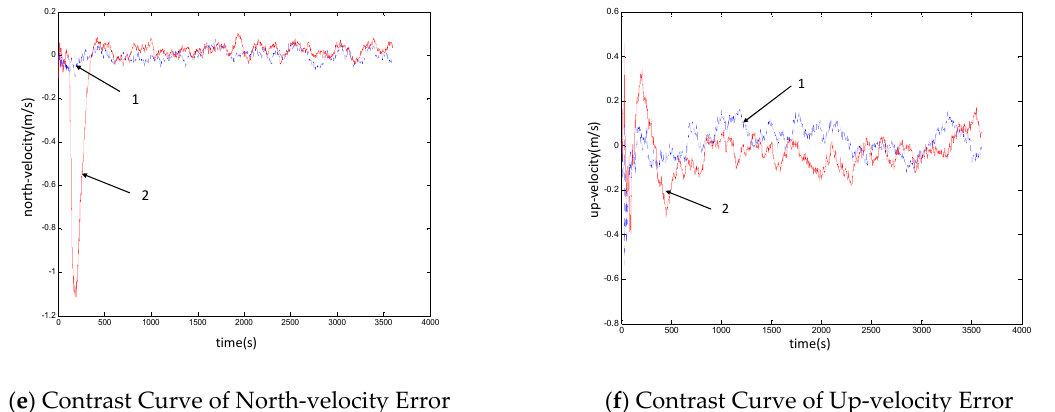
( e ) Contrast Curve of North-velocity Error ( f ) Contrast Curve of Up-velocity Error Figure 6. Contrast Diagram of System Self-regulation Fusion Navigation Results When the inertial sensor Fails.